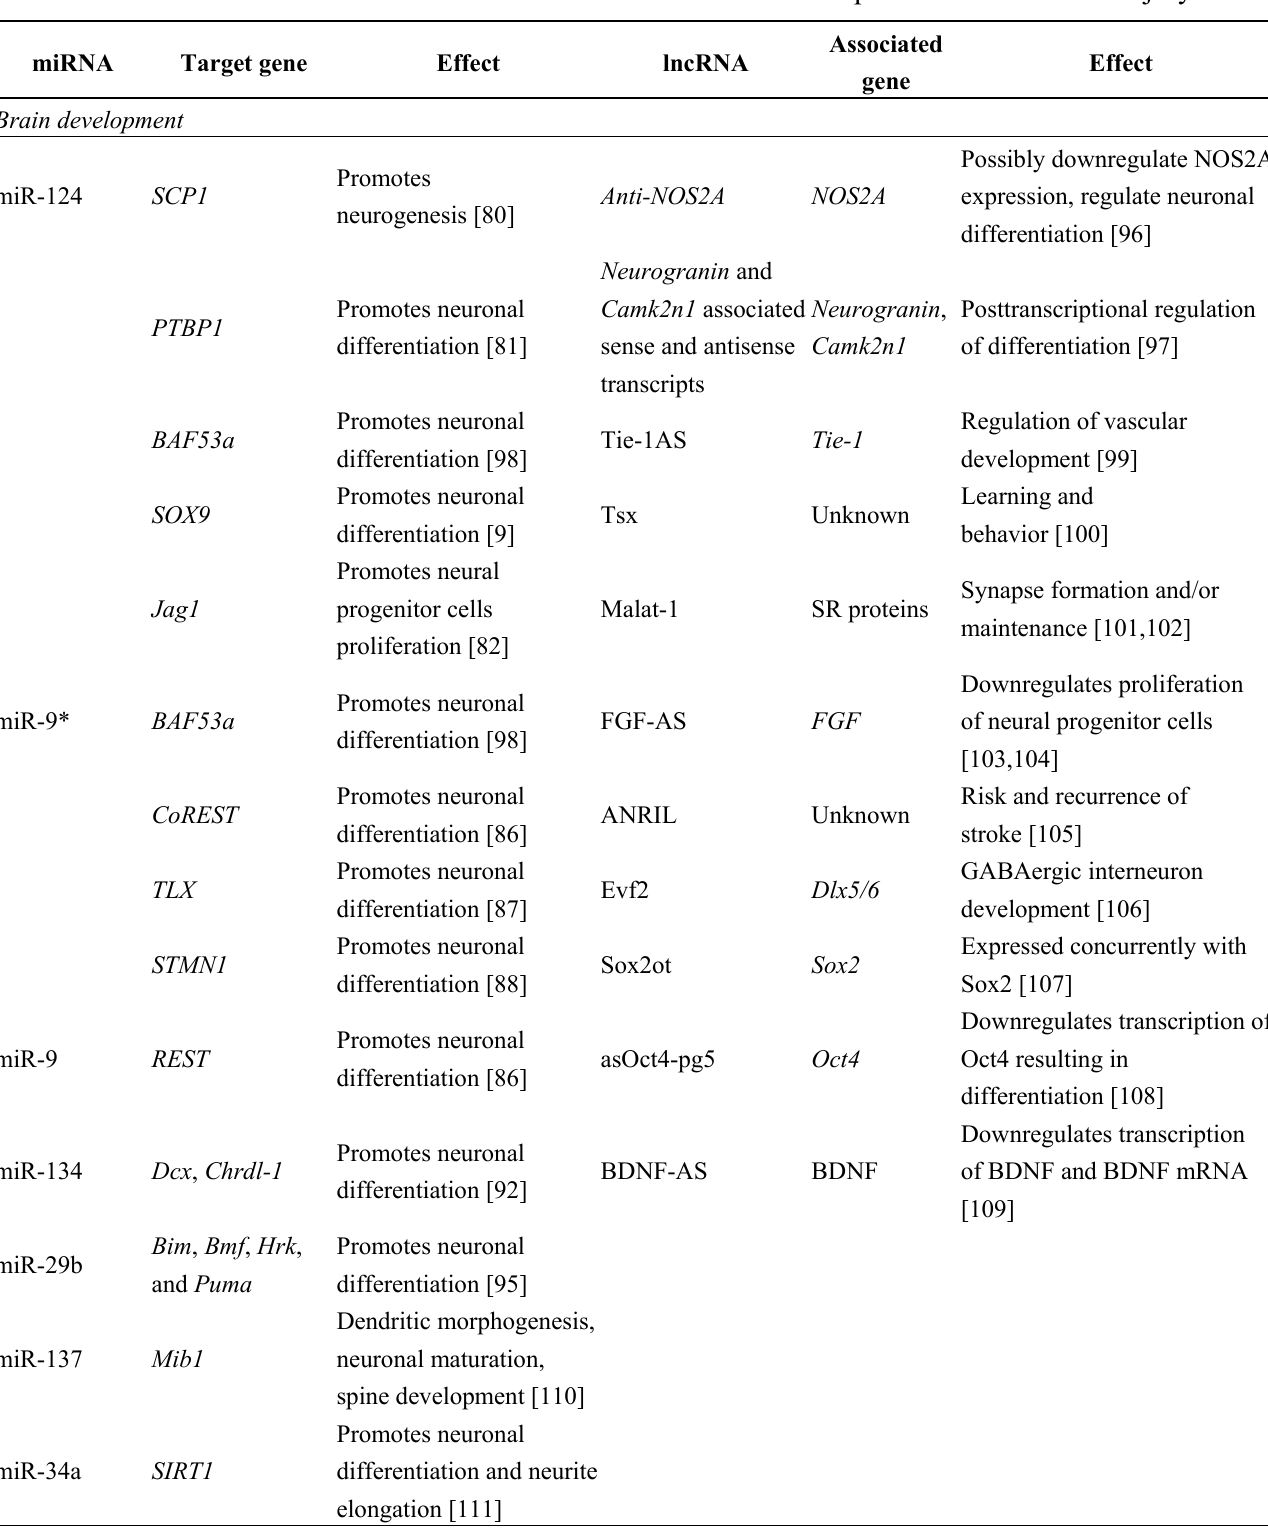
Table 2. List of miRNAs and lncRNAs involved in the different processes in ischemic injury. miRNA Target